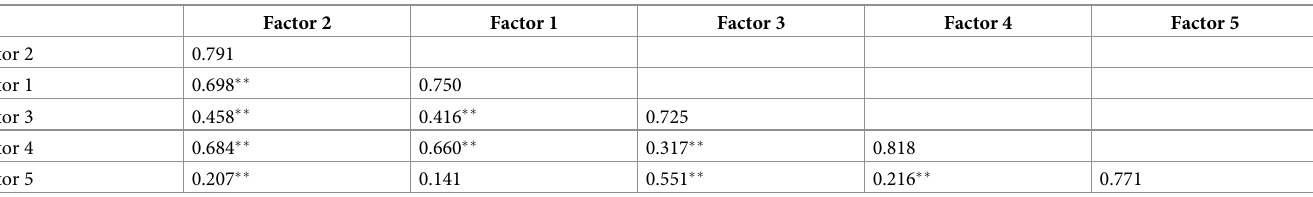
In this formula, OS denotes the overall satisfaction of residents, β ORD and d indicate the high- and low-performing dummy variables of the i th attribute, and d ri pi while β and β represent the impacts of the higher and lower performances of the i th attribute ri pi on overall satisfaction; ε is the residual. The results showed significant differences between the performance levels (Table 6). Although the values are different at the same performance level, the impact is negative for low- performing attributes and positive for the high-performing ones.